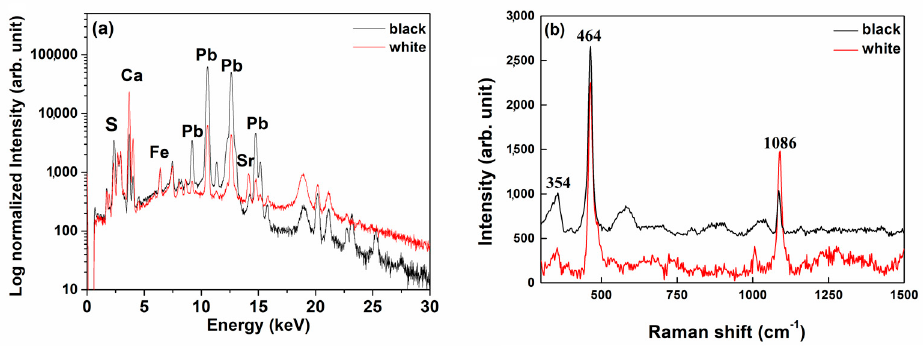
Figure 7. Two representatives ( a ) p XRF and ( b ) Raman spectra of the sheathings.